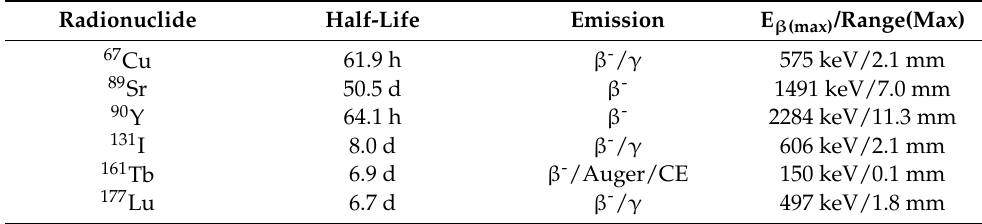
Table 1. The β - -emitters used in nuclear medicine, along with their basic properties. Data obtained from